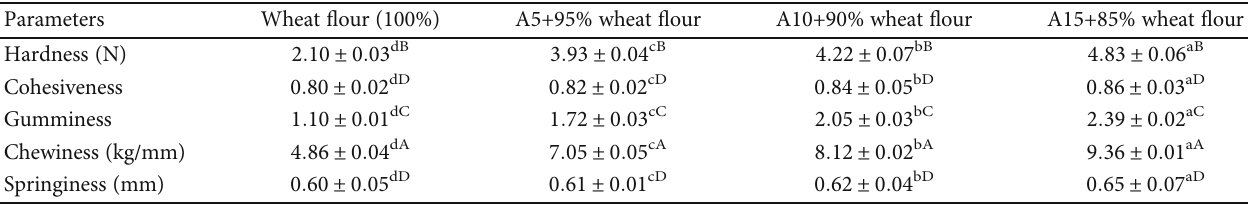
Table 8: E ff ect of texture pro fi le analysis (TPA) on hardness, cohesiveness, gumminess, chewiness, and springiness of bread substituted with amaranth fl our during storage.